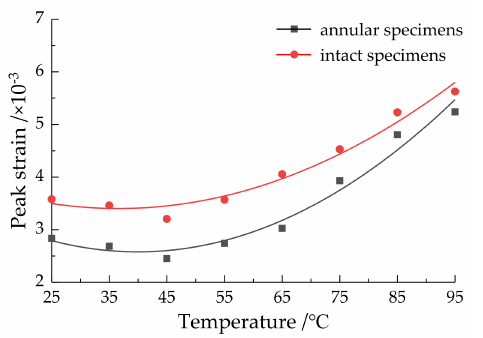
Figure 11. Relationship between peak strain and water